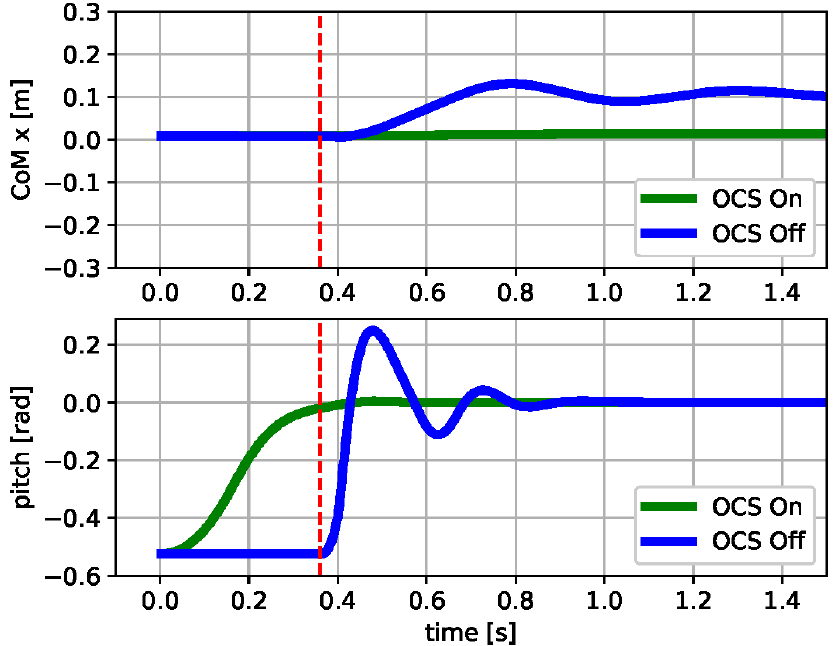
Figure 9. Second Test: simulation results showing the CoM x and pitch trajectory vs. time plots. The OCS drove the robot’s orientation during a fall so as to be horizontal. This allowed dampen- ing of the base oscillations after touch-down (vertical dashed line), even without implementing a landing